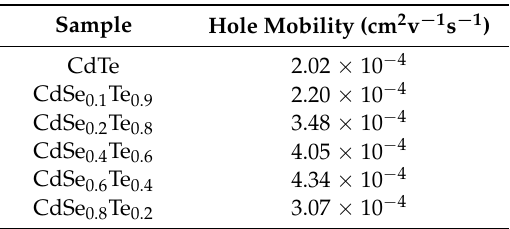
Table 1. Hole mobility of CdSe x Te 1 − x NC thin